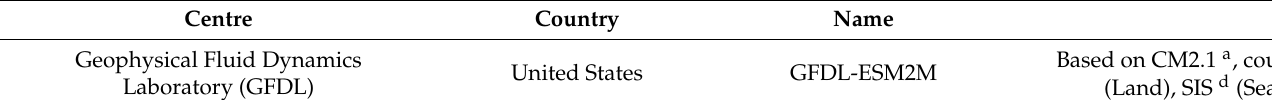
Building on HadGEM2-AO f by including the TRIFFID g dynamic vegetation model (terrestrial ecosystem), the Diat-HadOOC h model (Oceanic ecosystem) and the UKCA model i (Tropospheric chemistry) [27].